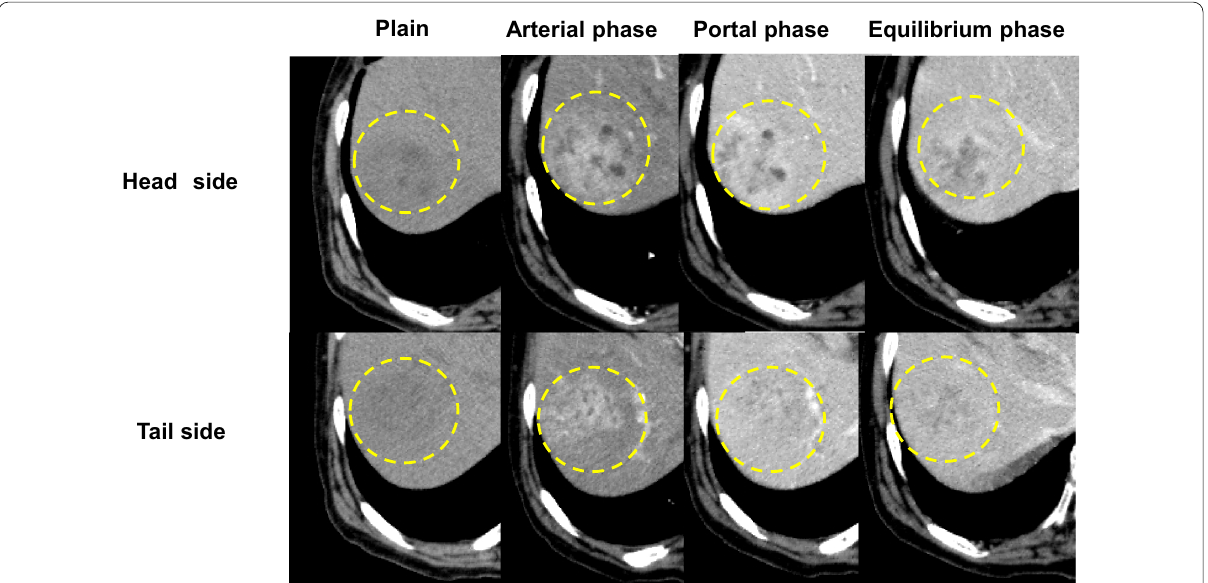
Fig. 2 Abdominal contrast-enhanced computed tomography (CT) scan. An abdominal contrast-enhanced CT scan revealed a tumor 3 cm in size in liver segment 8 that showed heterogeneous enhancement in the arterial phase and washed out insufficiently in the portal and equilibrium phase